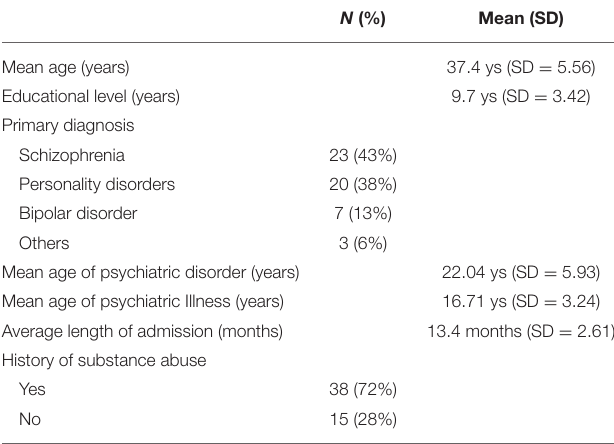
TABLE 1 | Socio-demographic, forensic and clinical data of sample ( N =